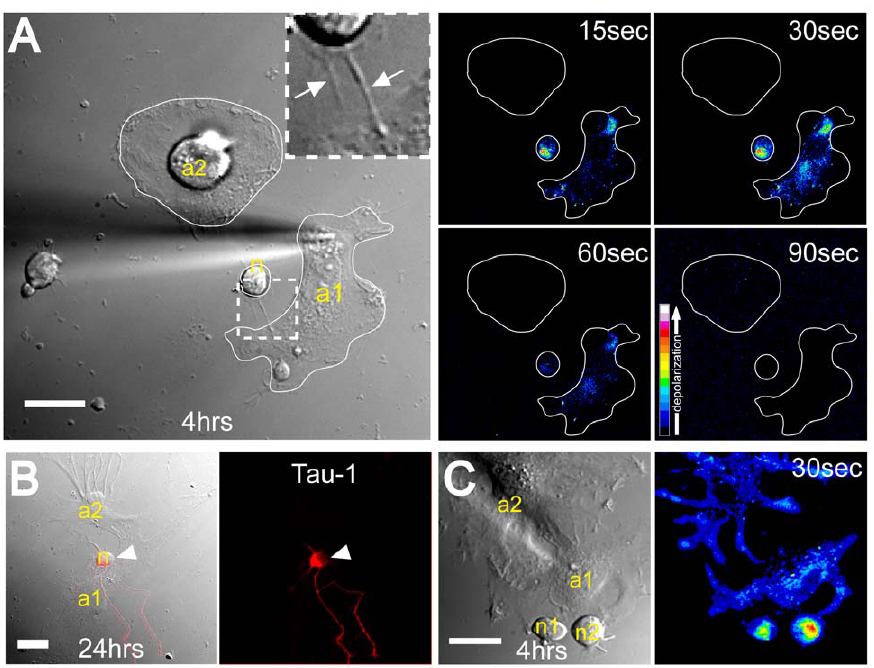
Figure 2. Depolarization signals spread between TNT-connected neurons and astrocytes. ( A ) Neurons and astrocytes are electrically coupled via TNTs. The DIC image shows the mechanically stimulated astrocyte (‘‘a1’’), the TNT-connected putative neuron (‘‘n’’), and a control cell (‘‘a2’’) after 4 hours of co-culture. The magnification box displays the TNTs ( arrows ). The pseudo-colored images, generated by subtraction of the image before stimulation from the respective images acquired after indicated times of stimulation, show the transient increase of DiBAC 4 (3) fluorescence after mechanical stimulation. The color bar indicates relative levels of depolarization. ( B ) After mechanical stimulation, the co-culture was continued for additional 24 hours. Then the cells were fixed and subjected to immunofluorescence analysis using an antibody against tau-1 ( red ). The DIC image shows the cells (‘‘n’’, ‘‘a1’’ and ‘‘a2’’) at almost the same positions as in (A). The fluorescence image ( right ) depicts the tau-1 staining of neuron ‘‘n’’ in soma and dendrites ( arrowheads ). ( C ) Abutted cells display electrical coupling after 4 hours of co-culturing. The DIC image shows a close association of one astrocyte (‘‘a2’’) and two neurons (‘‘n1’’ and ‘‘n2’’). All three cells are electrically coupled as indicated by the increase of DiBAC 4 (3) fluorescence after 30 sec (pseudo-colored fluorescence image, right ). Scale bars=20 m m.